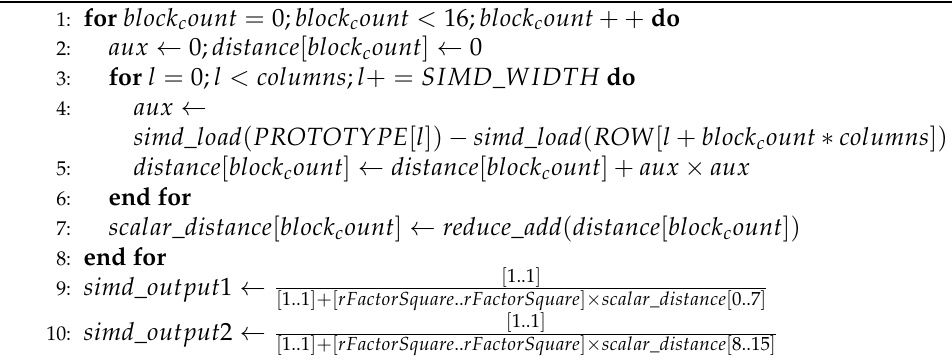
Algorithm 9: Superblocked SIMD version of Algorithm 5 line 5 (16 iterations) for a vector register of 8 doubles